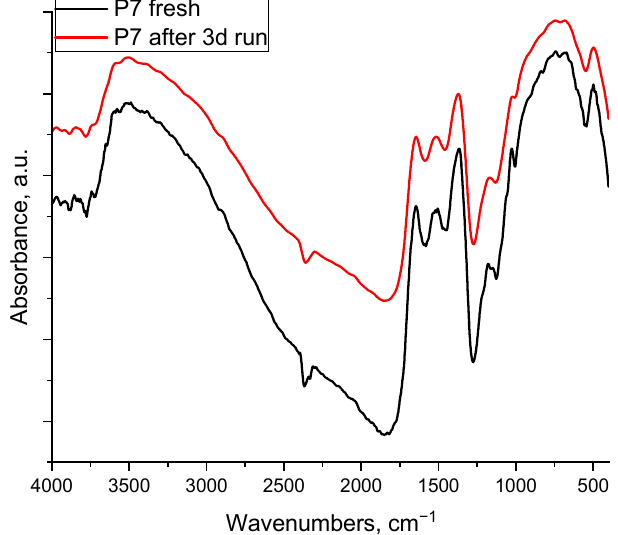
Figure 7. DRIFT spectra of fresh and spent P7 sample.